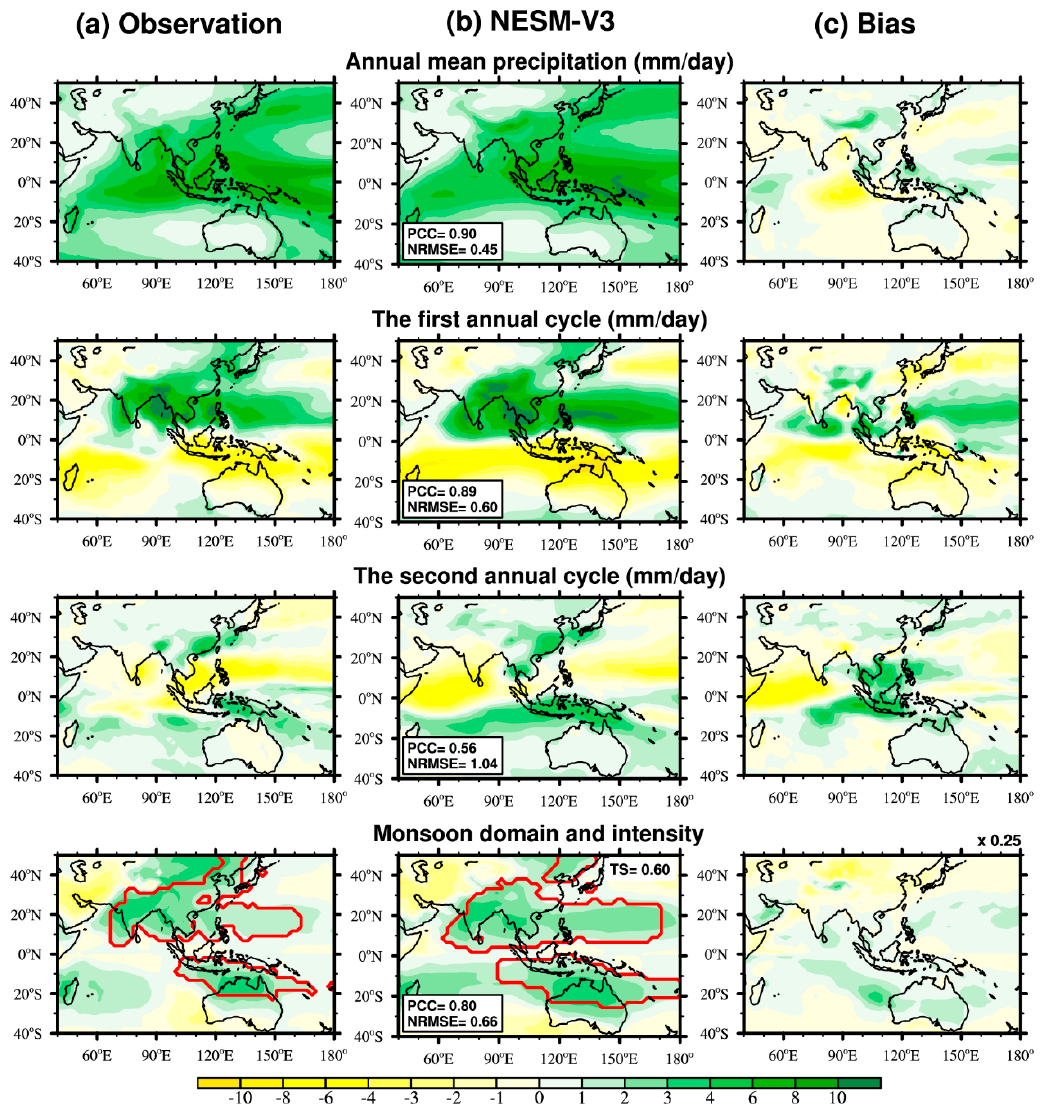
Figure 1. Comparison of ( a ) observed and ( b ) NESMv3-simulated monsoon climatology for 1979–2005, and ( c ) bias between ( b ) and ( a ) in terms of annual mean precipitation rate (mm/day), the first annual cycle mode (solstice mode, June-July-August-September minus December-January-February-March [29]), the second annual cycle mode (equinox asymmetric mode, April-May minus October-November [29]), and monsoon domain and precipitation intensity [15,29] (nondimensional and need to multiply 0.25 for the original value). The monsoon precipitation domain (outlined by red contours) is defined as the regions in which the summer-minus-winter precipitation exceeds 2.5 mm/day, and the summer precipitation exceeds 55% of the annual total [27], where summer denotes May-June-July-August-September (November-December-January-February-March) for the Northern Hemisphere (Southern Hemisphere). The numbers in the left lower corners indicate pattern correlation coefficient (PCC) and normalized root mean square error (NRMSE) between the observed and simulated patterns over 40 ◦ S–50 ◦ N, 40 ◦ E–180 ◦ . The number in the right upper corner indicates the threat score (TS) for the monsoon precipitation